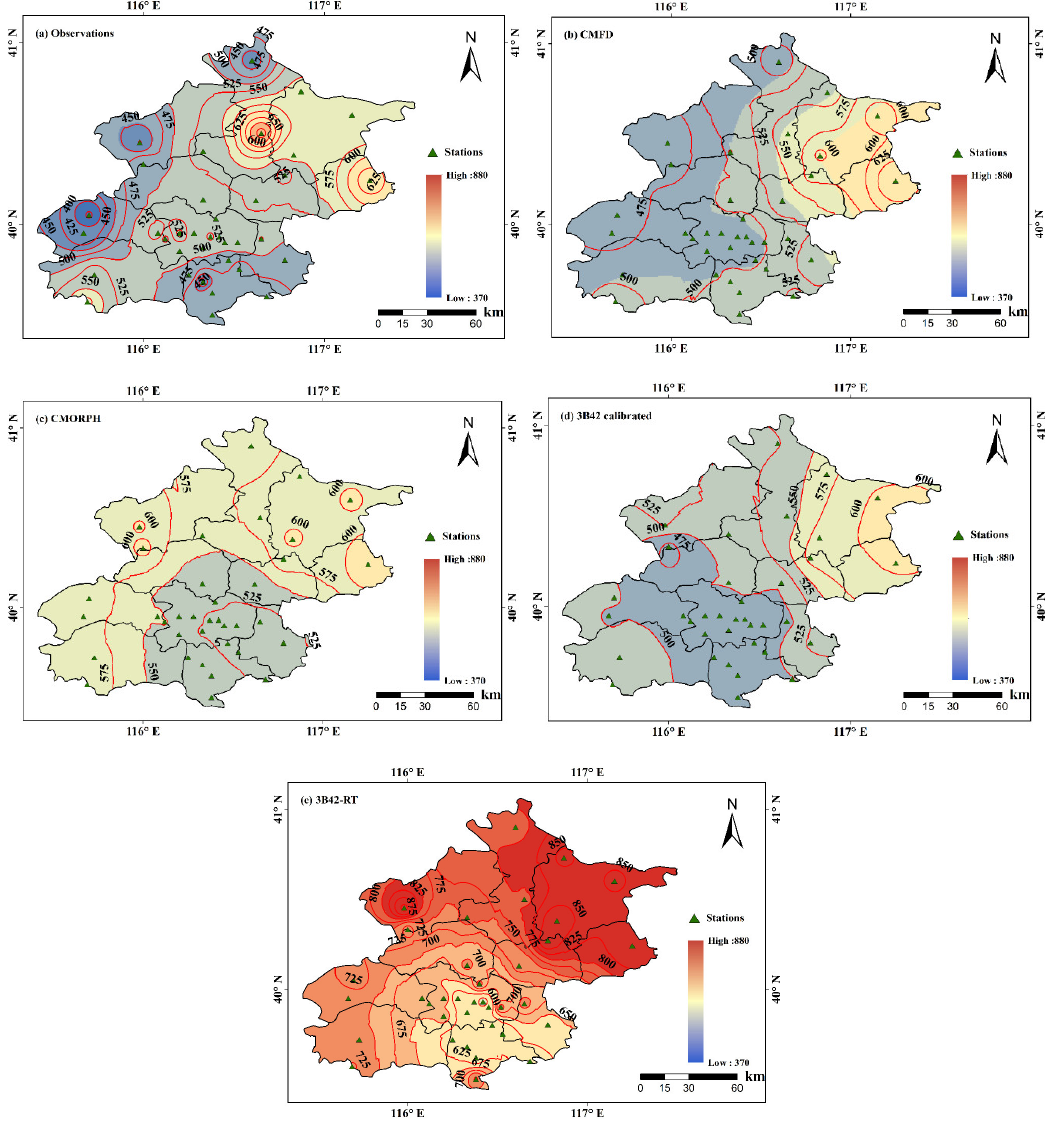
Figure 8. Spatial variability in the annual precipitation interpolated from ( a ) ground observations; ( b ) CMFD data; ( c ) CMORPH data; ( d ) 3B42 calibrated (version 7) data, and ( e ) 3B42-RT data.